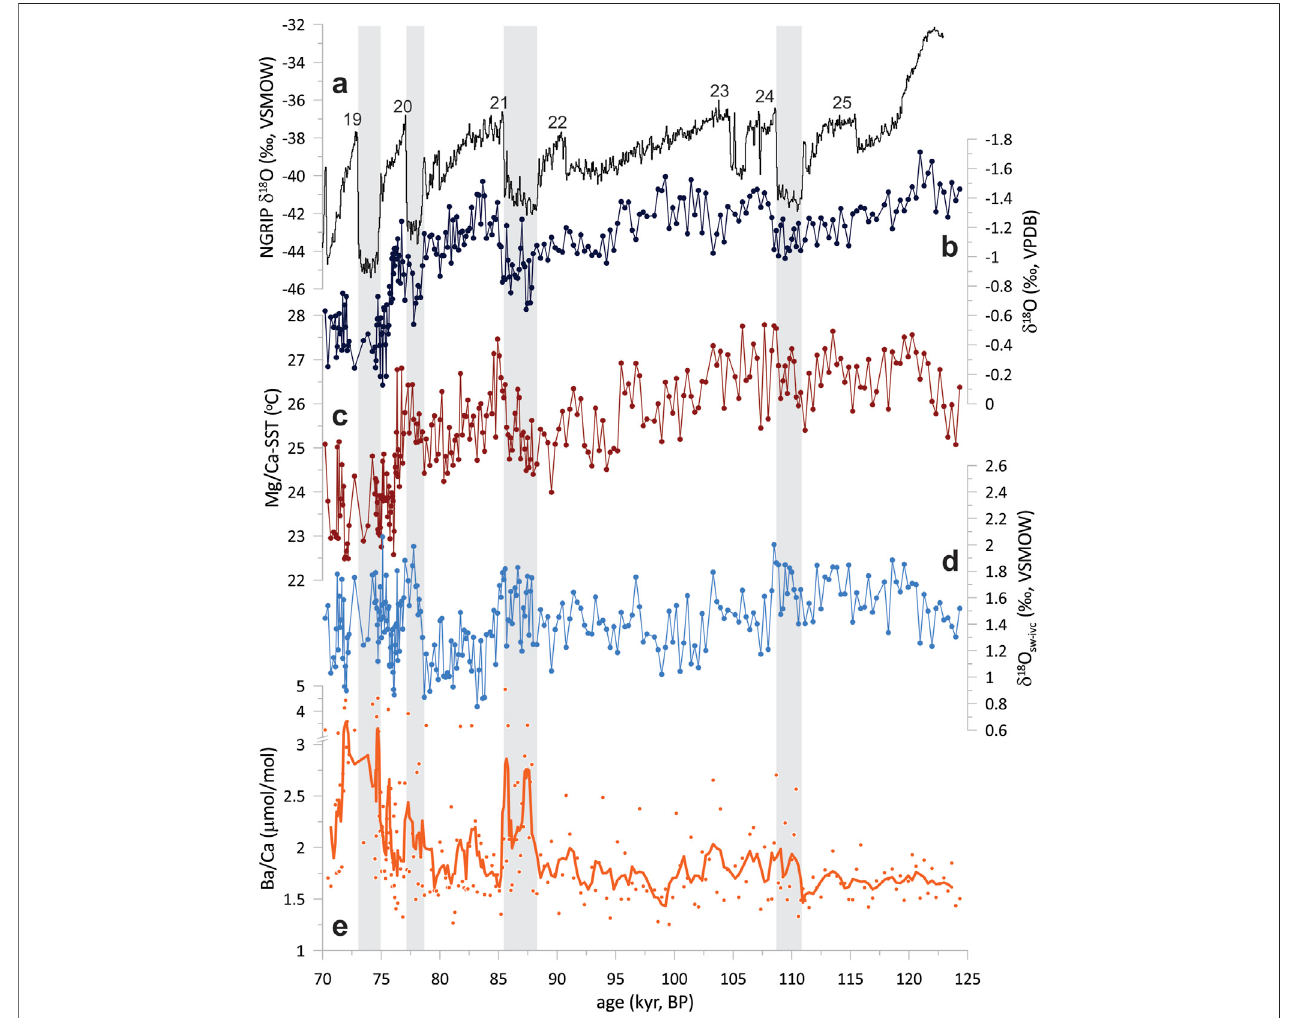
FIGURE2| GeochemicalresultsfromcoreGL-1248comparedtoNorthGreenlandIceCoreProject(NGRIP)icestableoxygenisotoperecord( δ 18 O ice ). (A) δ 18 O ice from NGRIP on the GICC05modelext time scale (Andersen e al., 2004; Wolff et al., 2010; black line). (B) δ 18 O of Globigerinoides ruber (white) from core GL-1248 (blue line). (C) Sea surface temperature (SST) derived from Mg/Ca of Globigerinoides ruber (white) from core GL-1248 (red line). (D) ice volume corrected δ 18 O of seawater ( δ 18 O sw-ivc )of Globigerinoidesruber (white)fromcoreGL-1248(lightblueline). (E) Ba/Caratiosof Globigerinoidesruber (white)fromcoreGL-1248(orangeline).Ba/ Caresultsareshownas5-pointrunning-averageofthedatapoints.Dansgaard-Oeschger (DO)stadialsaremarkedbythegreybars,andthenumberoftheDOcyclesis exhibited in panel